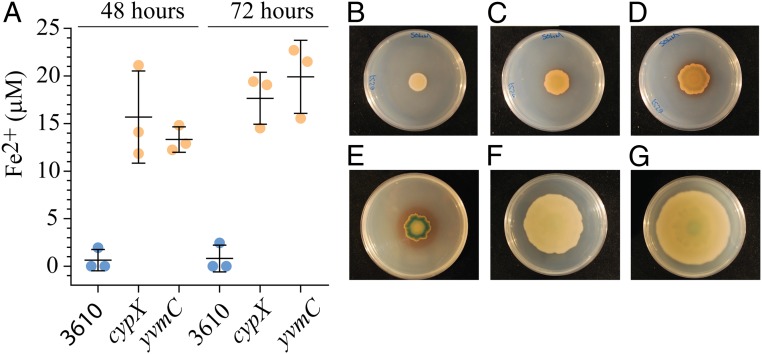
Detection of iron depletion is heterogeneous in the population. (A) The level of available ferrous and ferric iron in the agar under the colony was detected using a ferrozine assay. The bar represents the average of the biological repeats that are presented as individual points; the error bars are the SD. Biofilms formed by NCIB 3610 and the cypX (NRS5532) and yvmC (NRS5533) deletion strains were grown at 30 °C on MSgg agar containing 50 μM FeCl3 for the times indicated before analysis of the agar. (B–G) Images of strains containing the PdbhA-lacZ transcriptional reporter fusion after growth at 30 °C on MSgg agar in 9-cm-diameter Petri dishes containing 120 μg⋅mL−1 X-Gal. (B–E) The 3610 PdbhA-lacZ after 24, 48, 72, and 120 h of incubation, respectively. (F) cypX PdbhA-lacZ at 120 h of incubation. (G) yvmC PdbhA-lacZ at 120 h of incubation. The image shown is representative of three biological repeats.